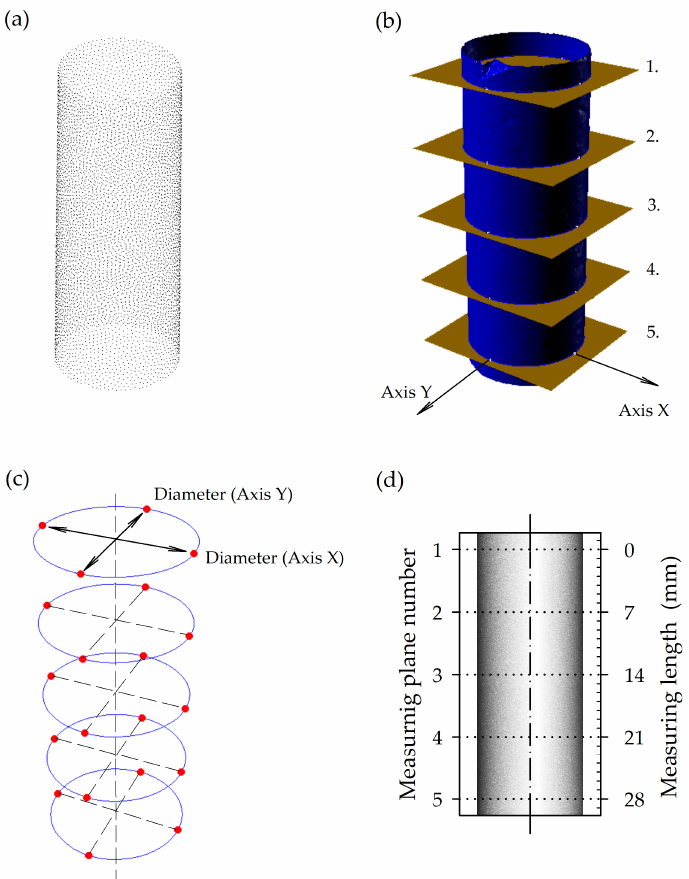
Figure 4. Processing of 3D scanning results: ( a )—point cloud, ( b )—surface model based on the point cloud with five cross sections, ( c )—cross-section figures with measure points, ( d )—front view of gypsum counter-sample with spaced measuring planes.